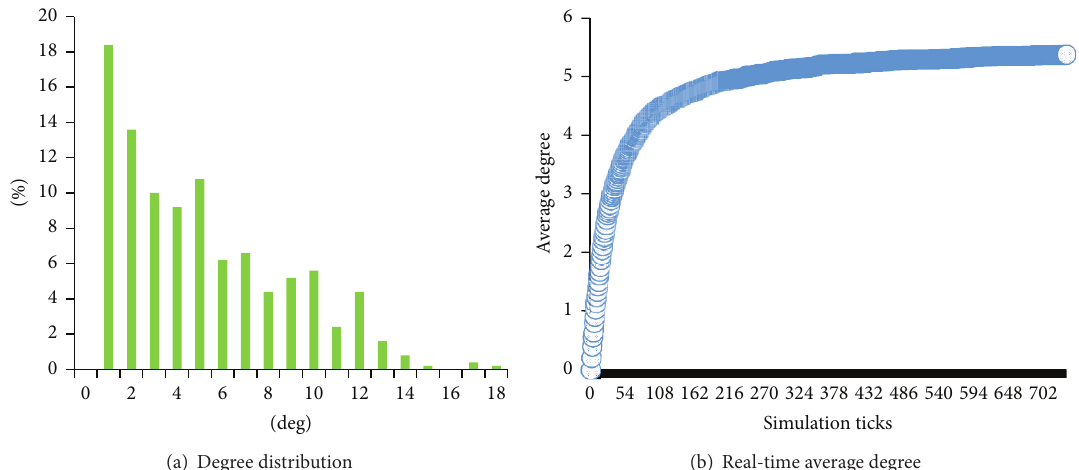
Figure 2: Degree distribution (a) and the average degree (b), where 𝑁 = 500 , 𝛼 = 1 , 𝛽 = 10 , 𝑚 = 5 , 𝜅 = 0.00005 , 𝑝 1 = 1 , and 𝜆 = 0.3